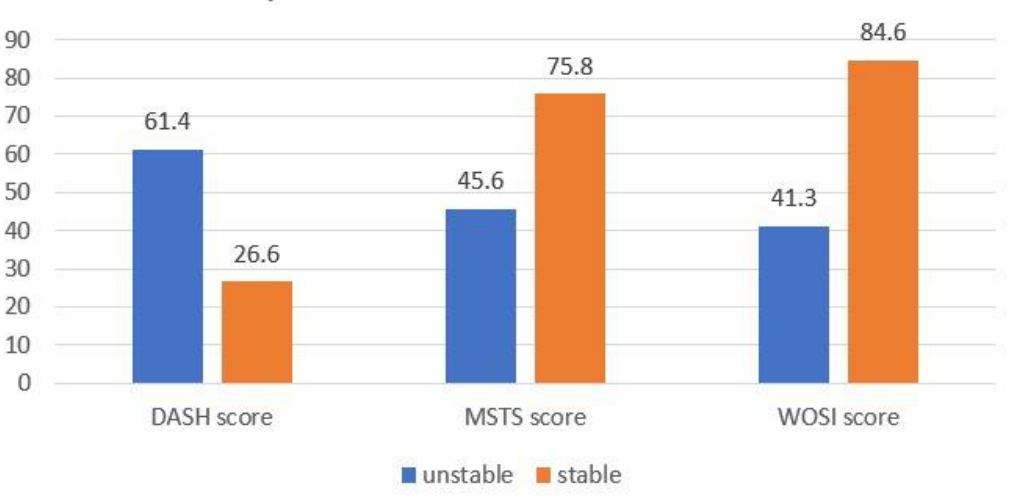
Figure 2. Stable vs. unstable patients. Reporting results of DASH, MSTS, and WOSI scores in patients who felt stable compared with those who felt instability in their shoulders.